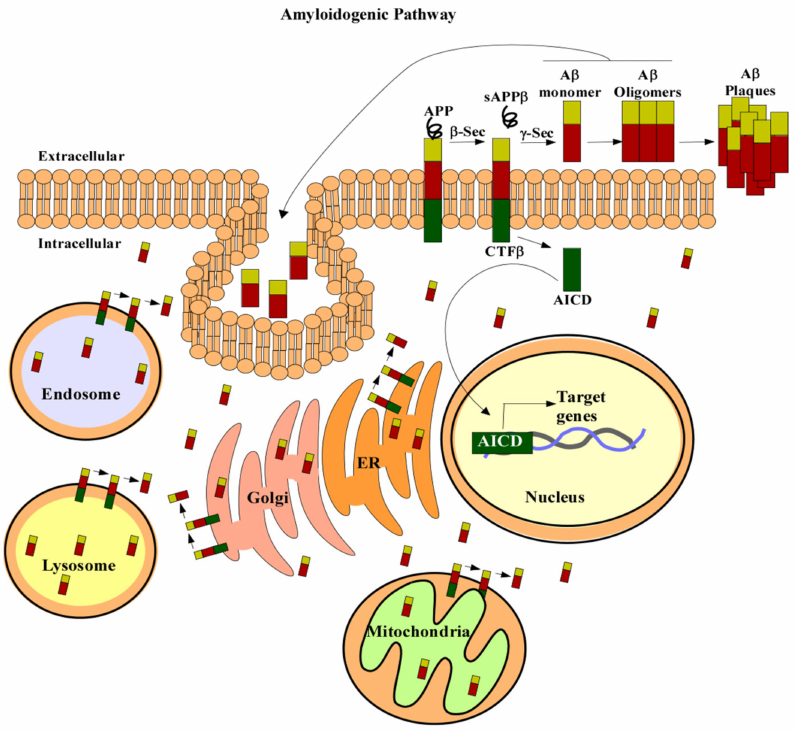
Figure 1. APP processing. In the amyloidogenic pathway APP (in green red and gold) is cleaved by β secretase to produce a soluble form of APP, sAPP β . Then, γ -secretase cleaves the remaining amino acid protein CTF β to produce A β (red and gold) and AICD (green). A β can then form oligomers and plaques which are characteristic of AD. AICD can translocate to the nucleus (beige) and regulate gene expression (DNA is in grey and blue). APP can also be localized to the trans-Golgi network (pink), ER (orange), endosomal (blue), lysosomal (yellow), and mitochondrial membranes (green). A β liberation can occur wherever APP and the β - and γ -secretases are localized. A β can also be taken up by the cell to form intracellular pools. Abbreviations: amyloid precursor protein (APP), secreted APP derivative (sAPP β ), amyloid beta (A β ), β -Secretase-Derived C-Terminal Fragment (CTF β ), APP intracellular domain (AICD), β -APP-site cleaving enzyme ( β -Sec), γ -Secretase (y-Sec), ER (endoplasmic